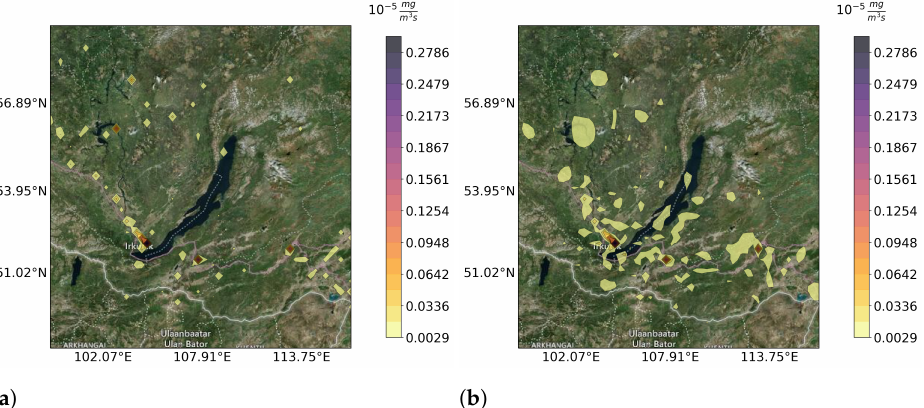
Figure 4. “Exact” configuration of emission sources ( a ) and reconstructed sources ( b ) of NO from